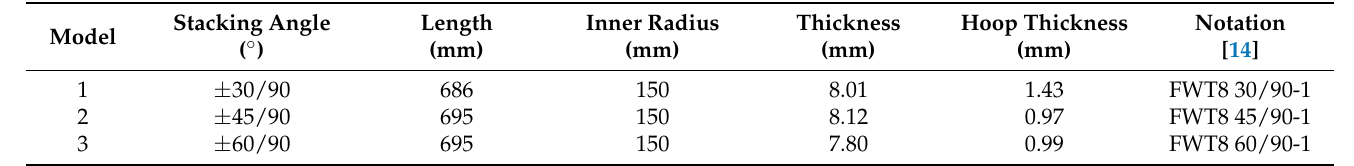
Table 4. Geometrical and material information (reproduced from [14], with permission from The Society of Naval Architects of Korea, 2022).